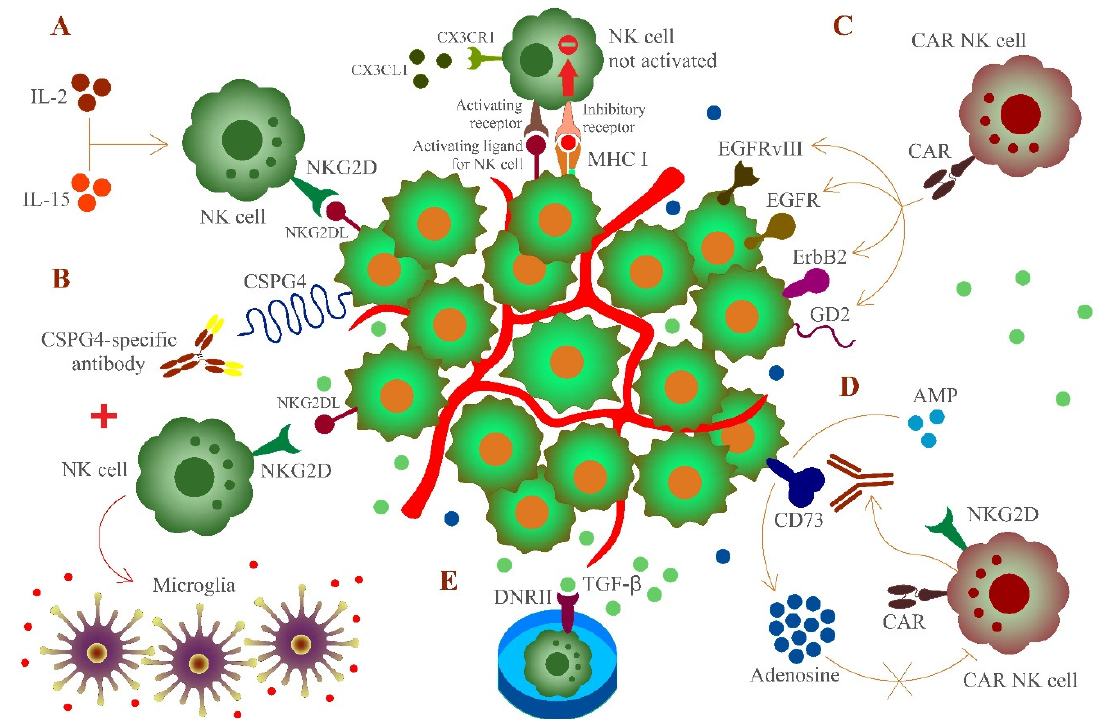
Figure 1. Targeting of glioblastoma cells expressing major histocompatibility complex class I (MHC I) molecules by activated or engineered natural killer (NK) cells. The chemokine receptor CX3CR1 is expressed on NK cells. NK cells can follow a CX3CL1 gradient to cross the blood brain barrier to the site of glioblastoma. However, glioblastoma cells partly express MHC I molecules to impair recognition by NK cells as an immune evasion strategy. To circumvent this obstacle in NK cell-mediated immunotherapy, several procedures were developed. ( A ) Induced upregulation of NKG2D or cytokine (IL-2 and IL-15) -activated NK cells can overcome immune surveillance, ( B ) combined use of activated NK cells and monoclonal antibodies recognizing CSPG-4 leads to the recruitment of macrophages and differentiate to microglia, provoking a proinflammatory environment, ( C ) chimeric antigen receptor (CAR)-engineered NK cells can target epidermal growth factor receptor variant III (EGFRvIII), epidermal growth factor receptor (EGFR), ErbB2, or disialoganglioside GD2 on glioblastoma cells, ( D ) engineered NK cells expressing the GD2- and NKG2D-based CARs can locally release an antibody fragment which blocks the activity of CD73 and decreases adenosine concentration, which in turn is not able to inhibit NK cell function, and ( E ) umbilical cord blood (UCB)-derived NK cells expressing the TGF- β -dominant-negative receptor II (DNRII) that is able to consume TGF- β molecules, thereby counteracting the immune-suppressive tumor environment of glioblastoma. MHC I molecules and inhibitory receptors are not shown for all cells to improve the overview.